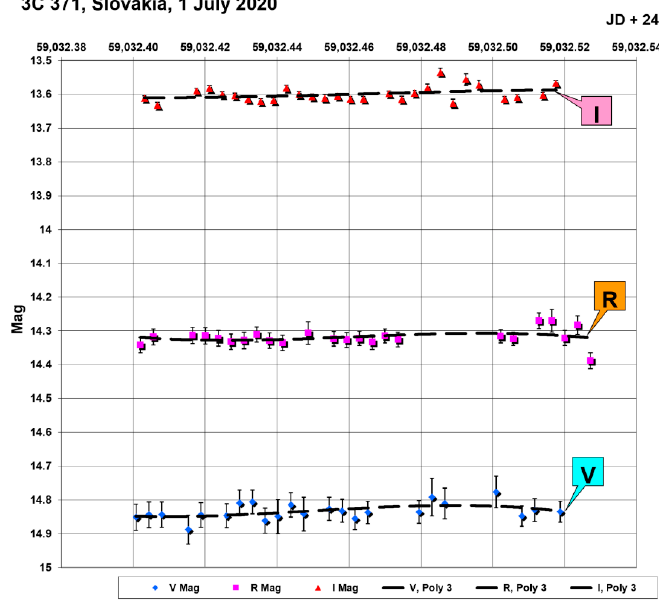
Figure 15. An example of light curves inside the night of 1 July 2020 in filters V, R, I (Vihorlat observatory). Dotted trend lines—third degree polynomials. Weak brightness variations are seen in the V and R bands with a characteristic time of about 20 min.